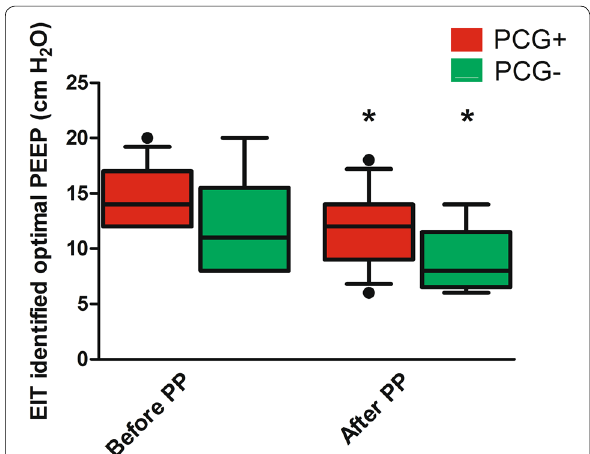
Fig. 5 Electrical impedance tomography (EIT)‑estimated optimal positive end‑expiratory pressure (PEEP) before and at the end of a prone positioning (PP) session, for patients with an increase of the static compliance by 3 mL/cmH 2 O (PCG ) (red) and patients ≥ − with static compliance < 3 mL/cmH 2 O, respectively (PCG ) − (green). Whiskers plots report the median central horizontal = line; interquartile range bottom and top box limits and 90% = percentile T bars, • outliers. * P < 0.05 vs. = =